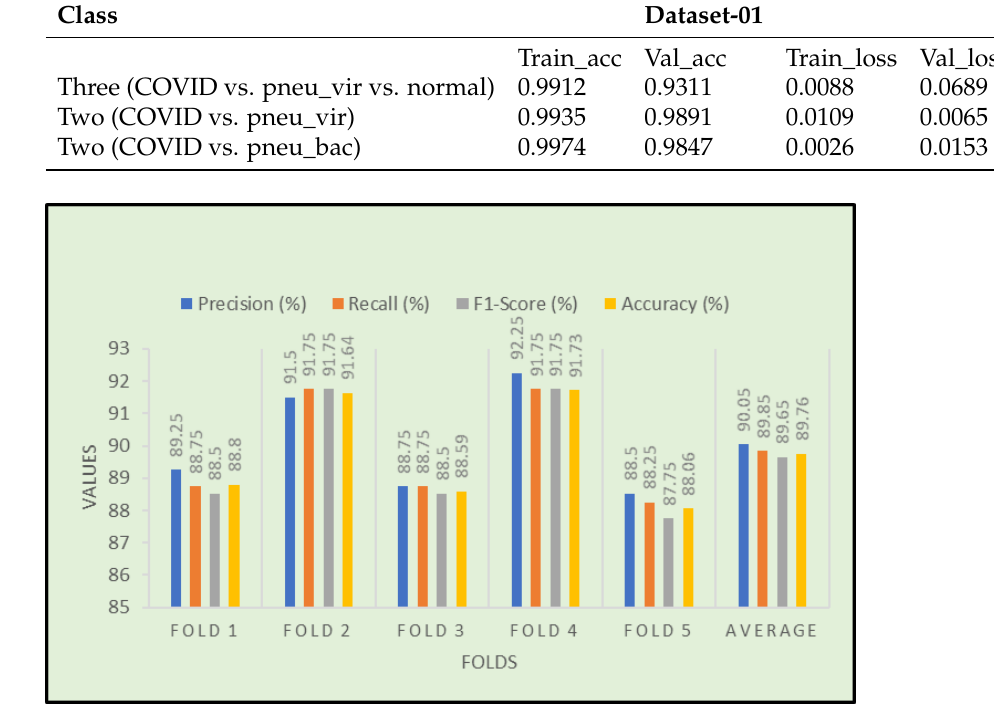
Figure 5. Performance results of the suggested model on each